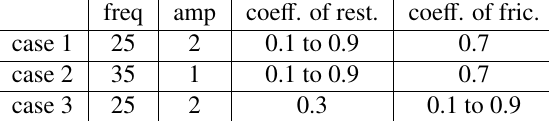
Table 1. Parameters used in the di ff erent simulated cases. Frequency is given in Hertz and amplitude in mm.